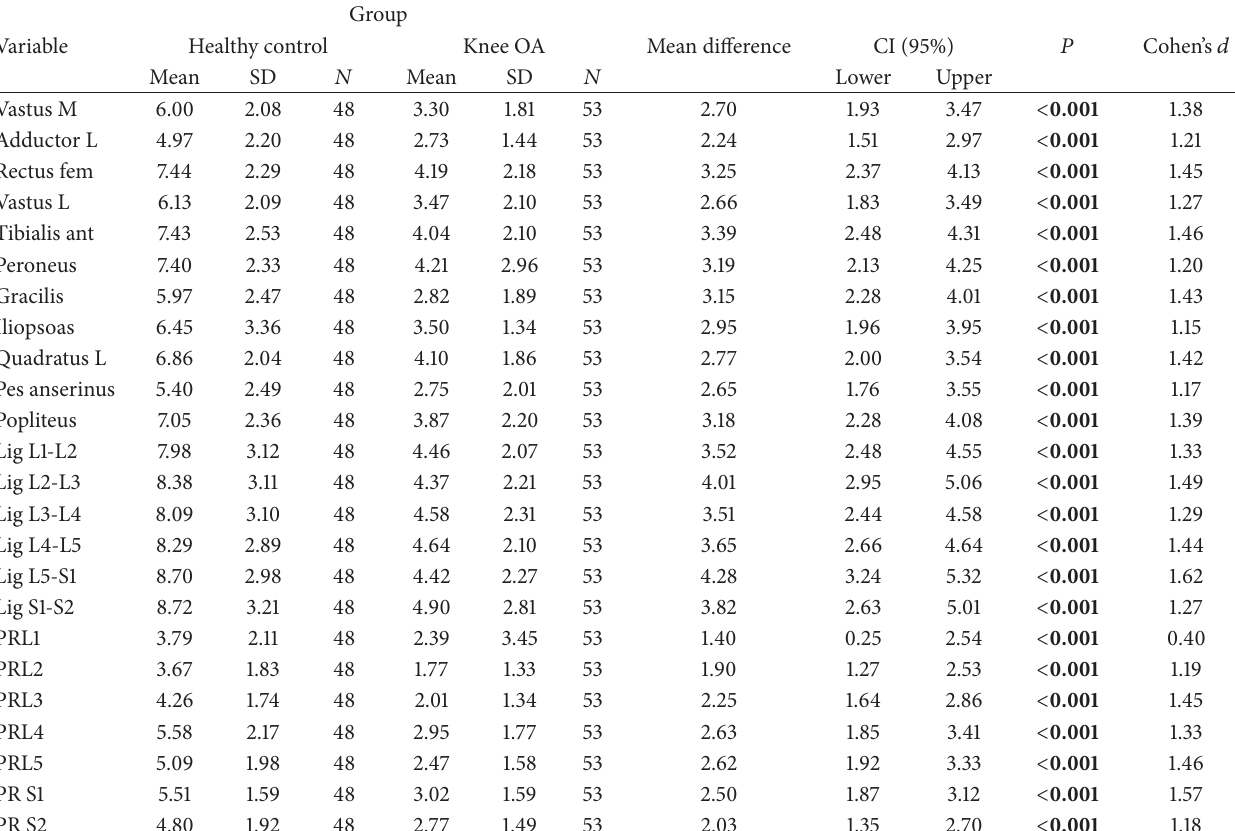
Table 2: Pressure pain threshold (PPT) values from the assessed structures. Group